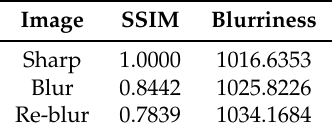
Table 1. Relationship between SSIM and image blurriness of Figure 1.